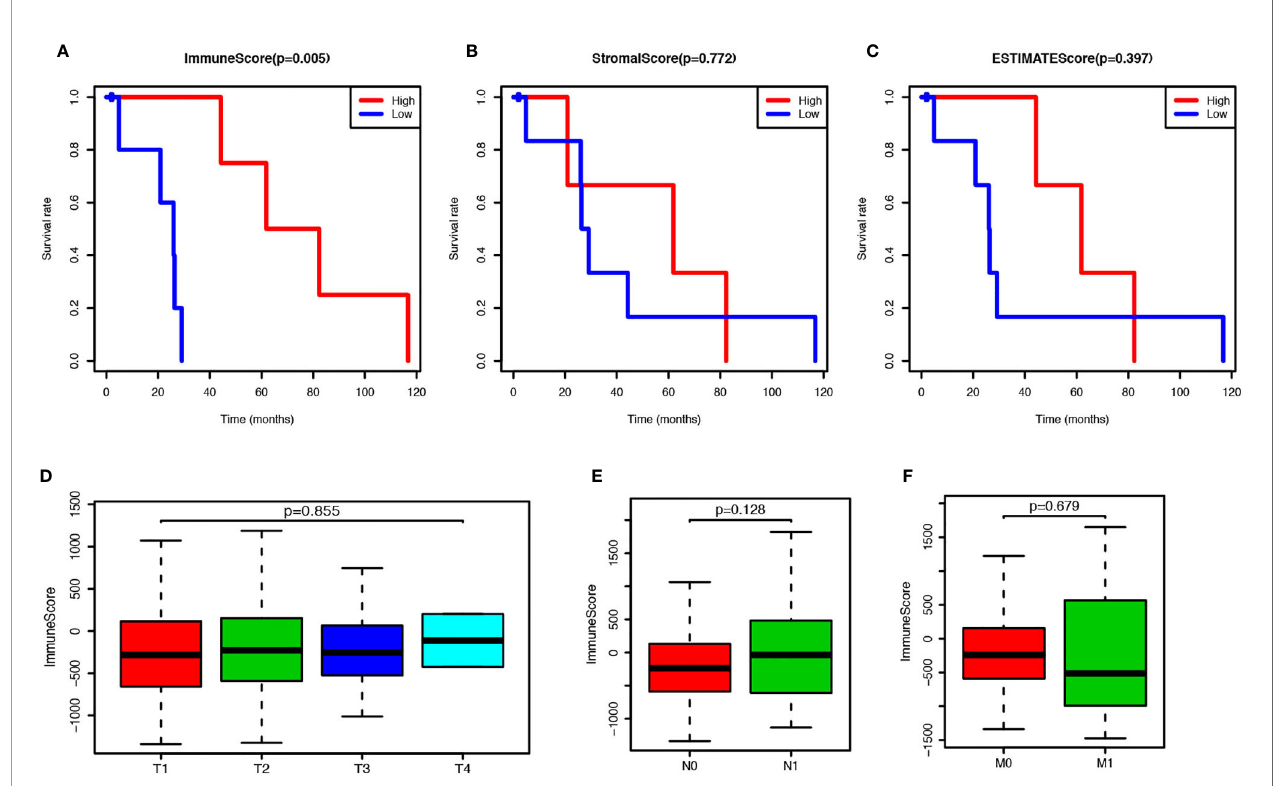
FIGURE 1 | Prostate cancer (PCa) patients with higher immune score have better prognosis. (A) PCa patients were divided into two groups according to the immune scores, and the survival rate of these two groups was shown as Kaplan-Meier survival curve, which indicated the PCa patients with higher immune score have better prognosis ( P = 0.005). (B) PCa patients were divided into two groups according to the stromal scores, and their survival rates did not show any signi fi cant difference ( P = 0.772). (C) PCa patients were divided into two groups according to the ESTIMATE scores, and there was no signi fi cant difference on survival rates between these two groups ( P = 0.397). (D) Immune scores of PCs patients in each tumor stage were shown by box-plot, but no signi fi cant association between the immune score and tumor stage was found ( P = 0.855). (E) Immune scores of PCs patients with or without lymph node metastasis were shown by box- plot, but there was no signi fi cant difference between the two groups ( P = 0.128). (F) Immune scores of PCs patients with or without metastasis were shown by box- plot, and no signi fi cant difference was shown between the two groups ( P =